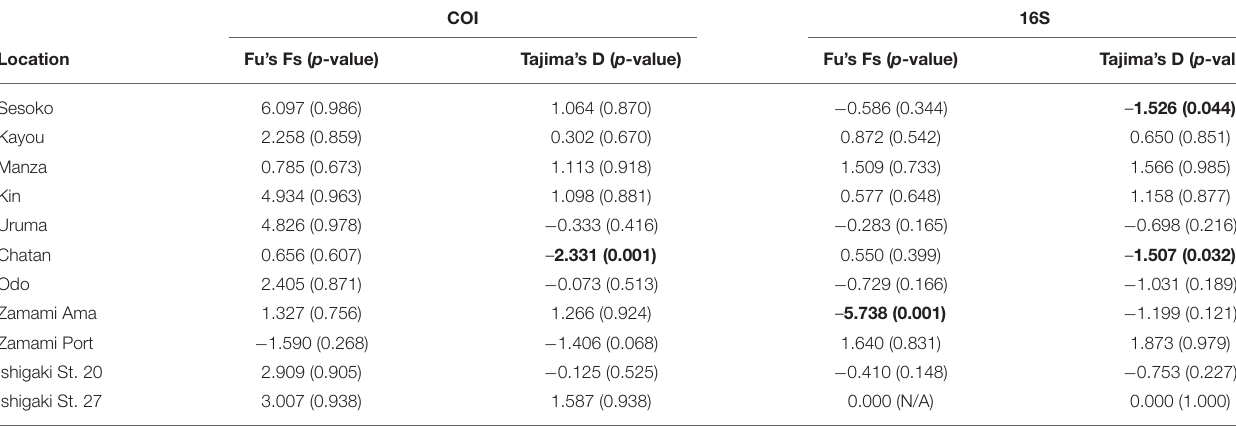
TABLE 4 | Results of neutrality test of sequences of H . atra from each location.